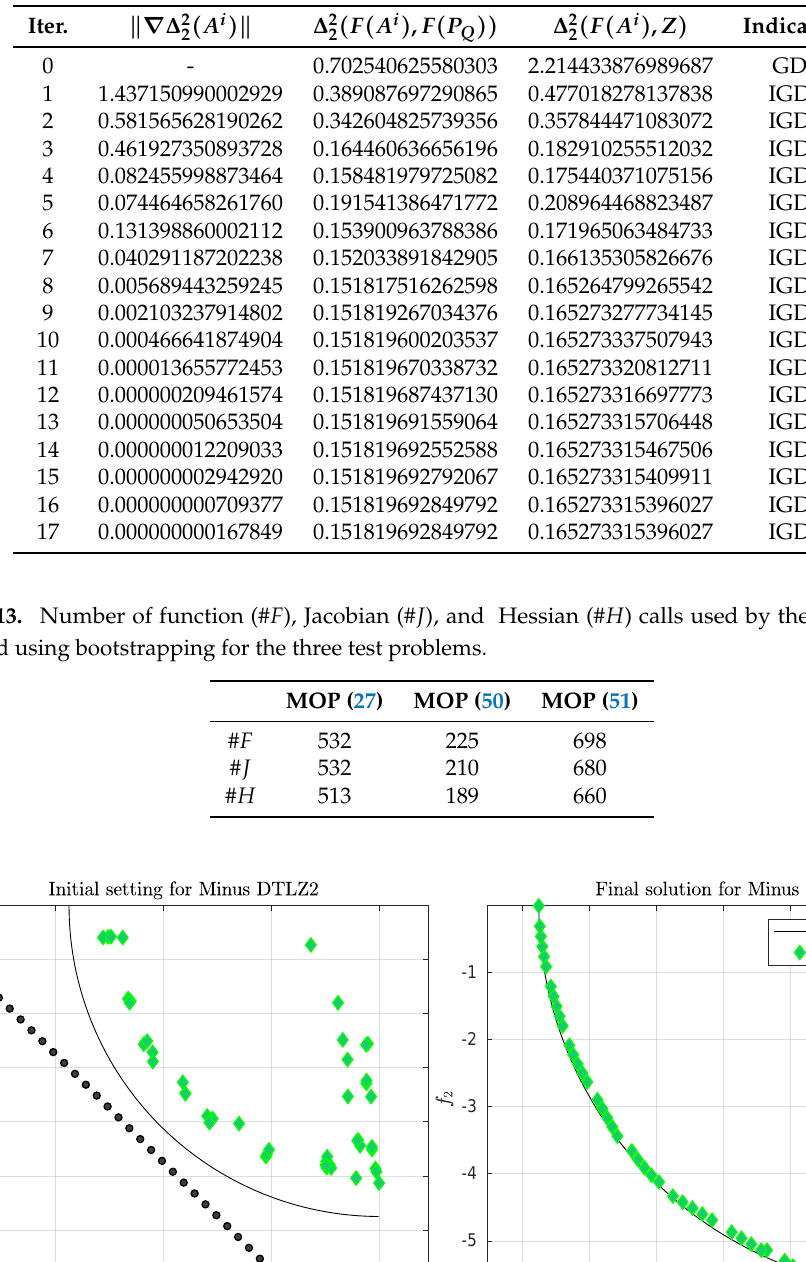
-Newton method to obtain the Pareto front of MOP (51) via the 2